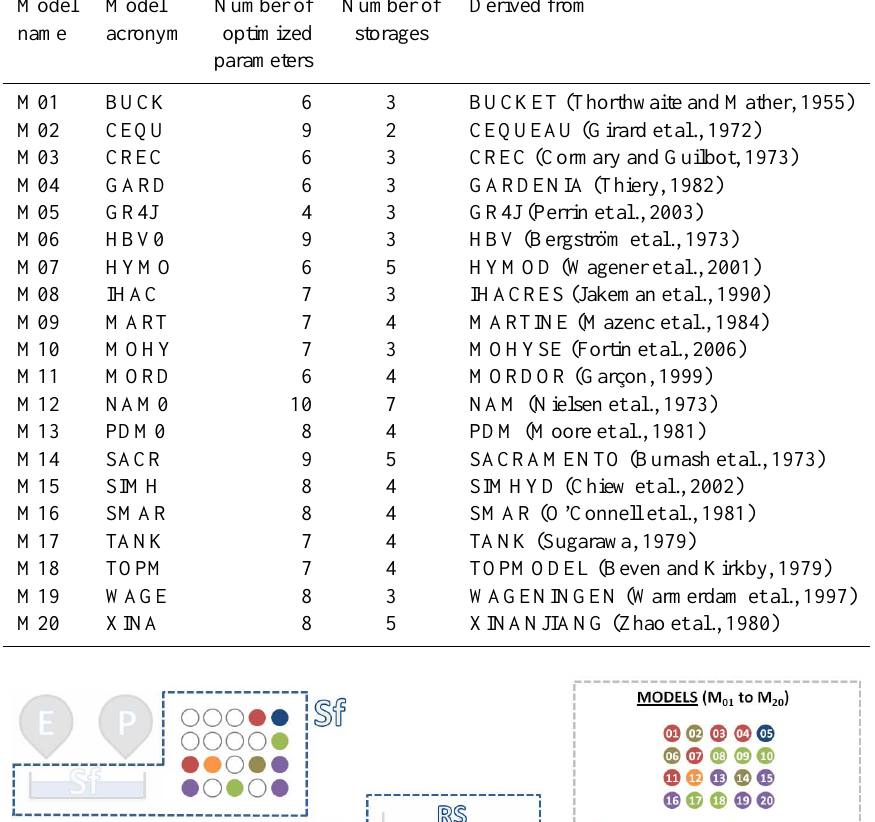
Table 2. Main characteristics of the 20 model versions used in the study.